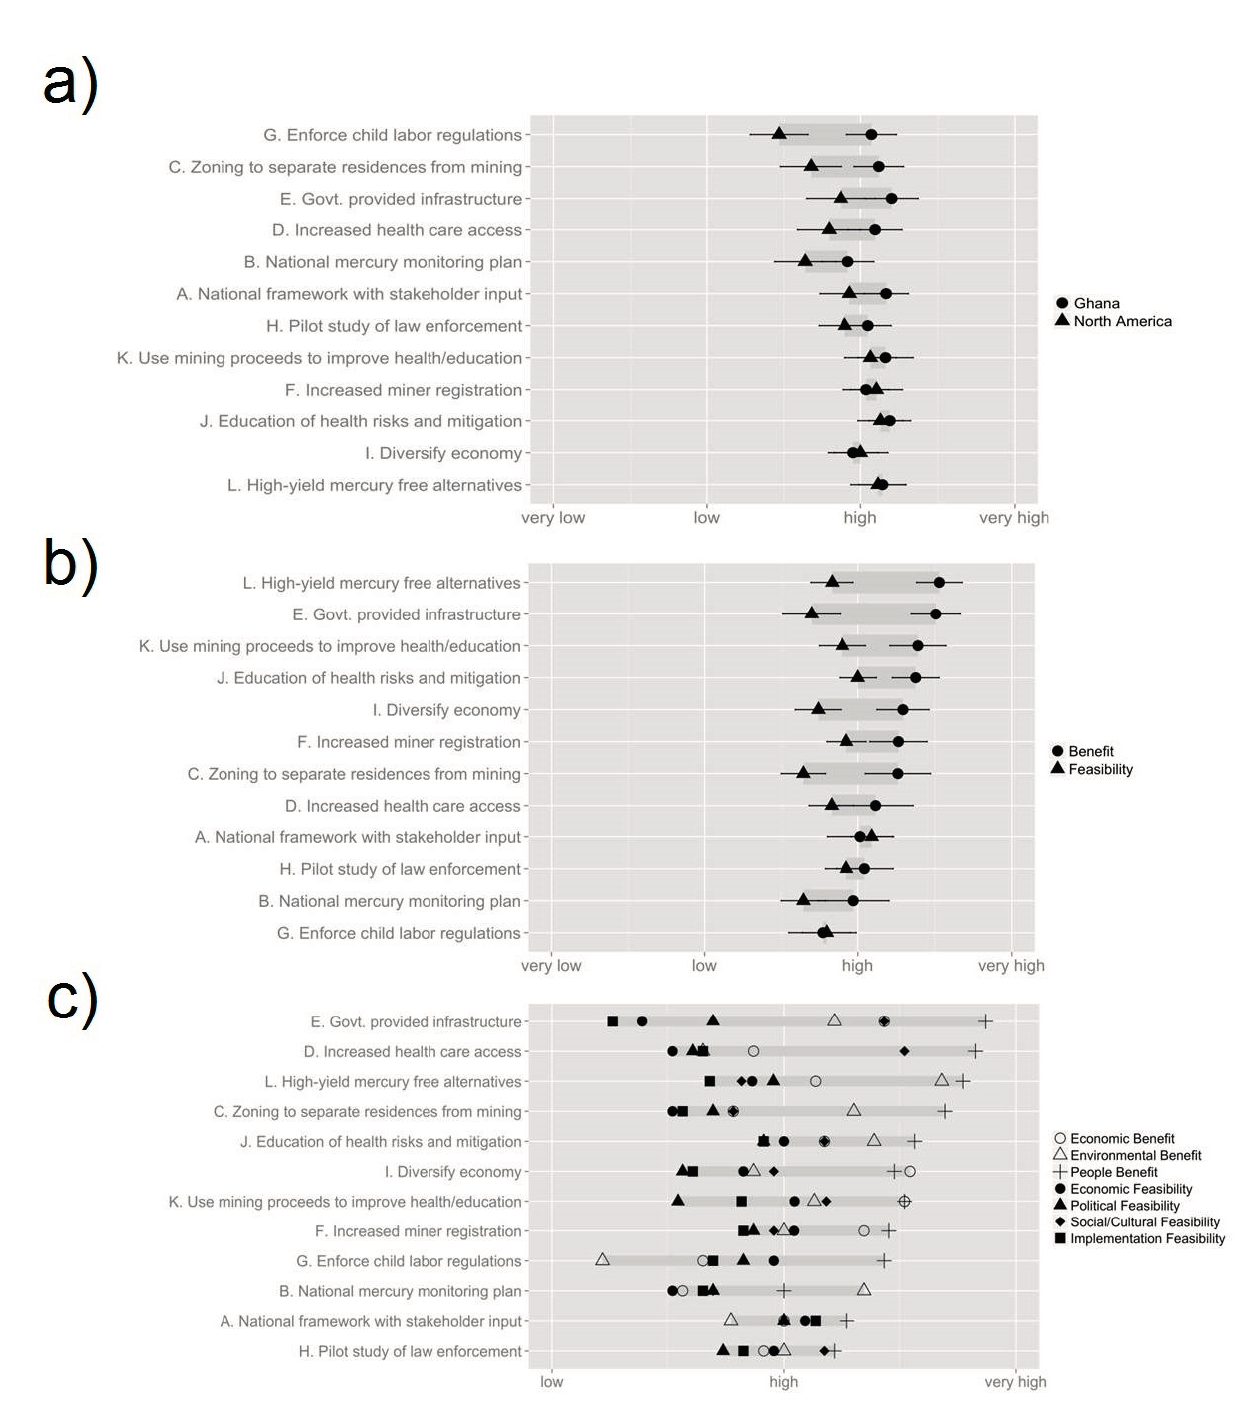
Figure 3. Delphi poll scores from the second Delphi poll, conducted among academics (n = 27) in April 2014. ( a ) Overall score for each option, grouped by region, sorted by difference; ( b ) Overall score for each option, grouped by benefit and feasibility, sorted by decreasing benefit; ( c ) Overall score for each option, grouped by topic, sorted by maximum